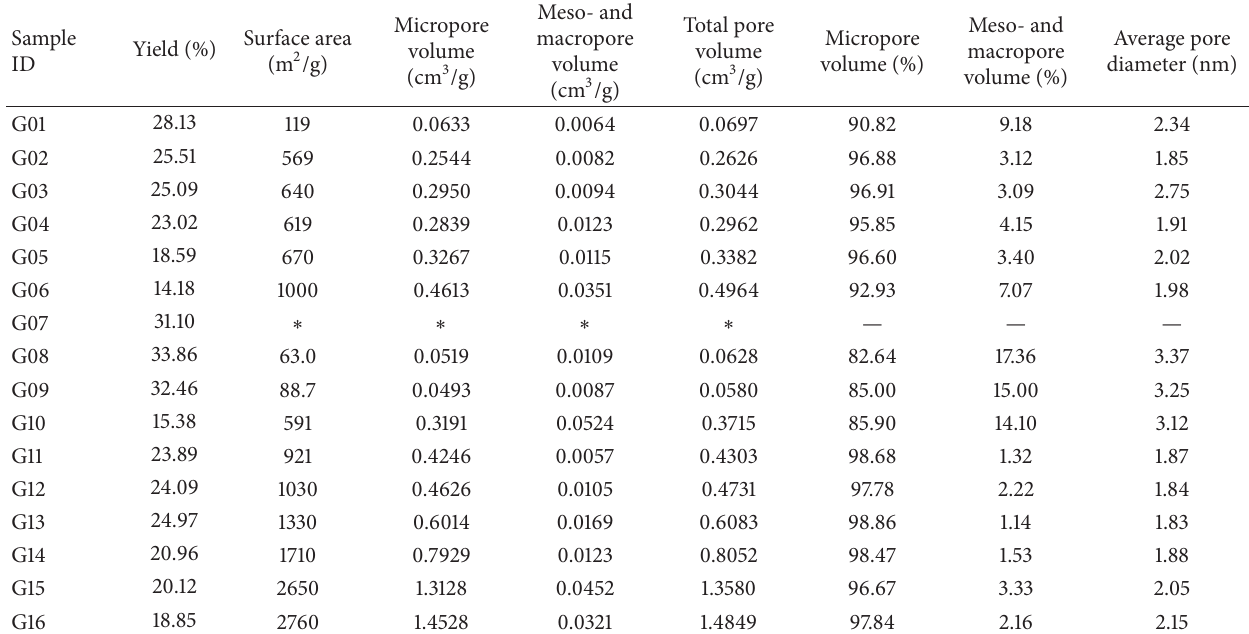
Table 4: Yields and porous properties of the activated carbons from various gasification conditions (see Table 1 for details of sample code). Sample